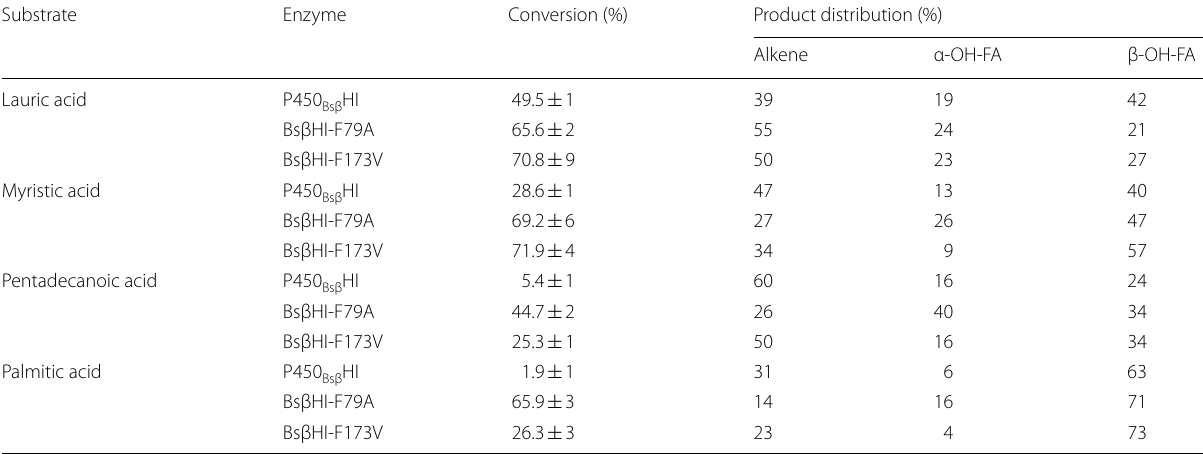
Table 2 Regioselectivity of P450